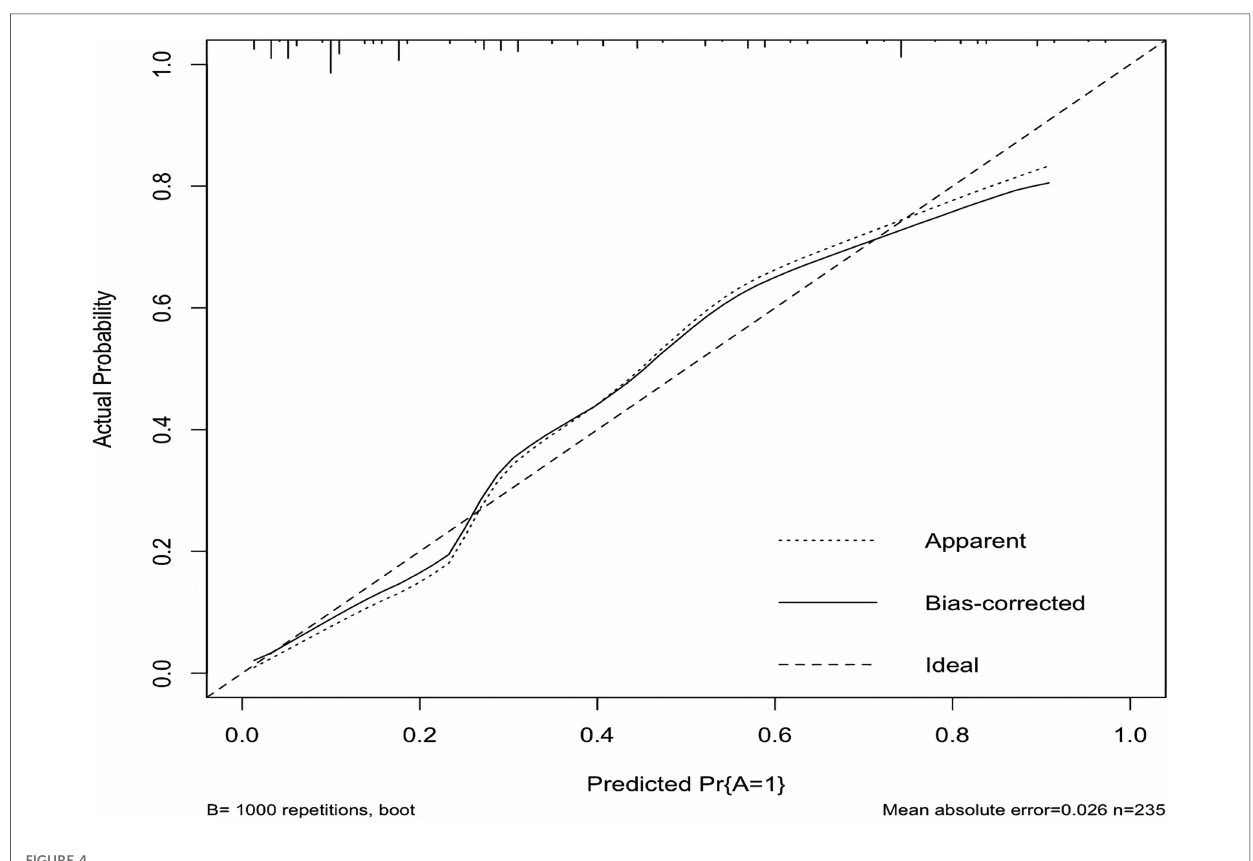
FIGURE 4 Clinical decision curve of nomogram